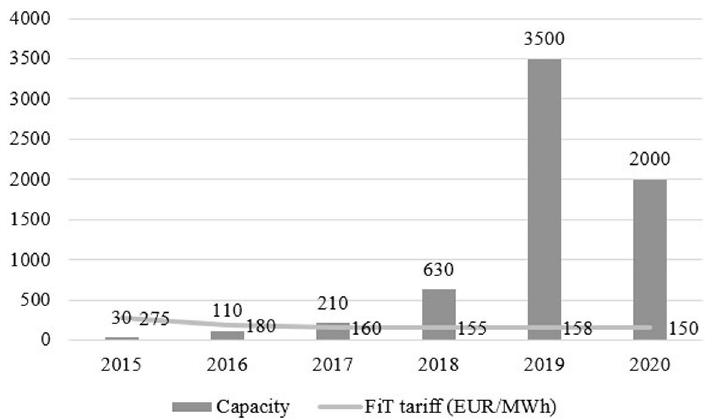
Figure 4. The total capacities of solar power plants and the FiT tariff of the multinational corporations (included in the sample). Source: calculated on the basis of data from official reports of multinational corporations and consulting agencies [21,29–33].